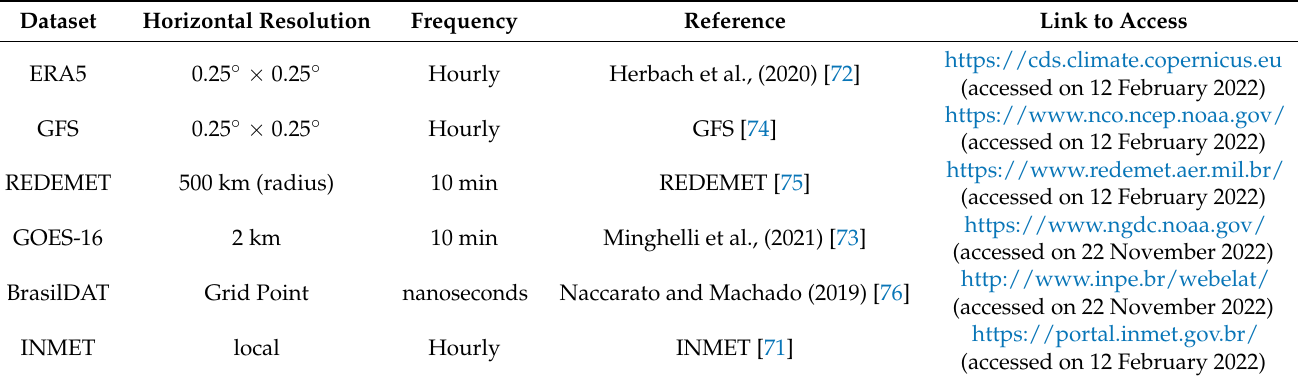
Table 1. Summary of the dataset used in the